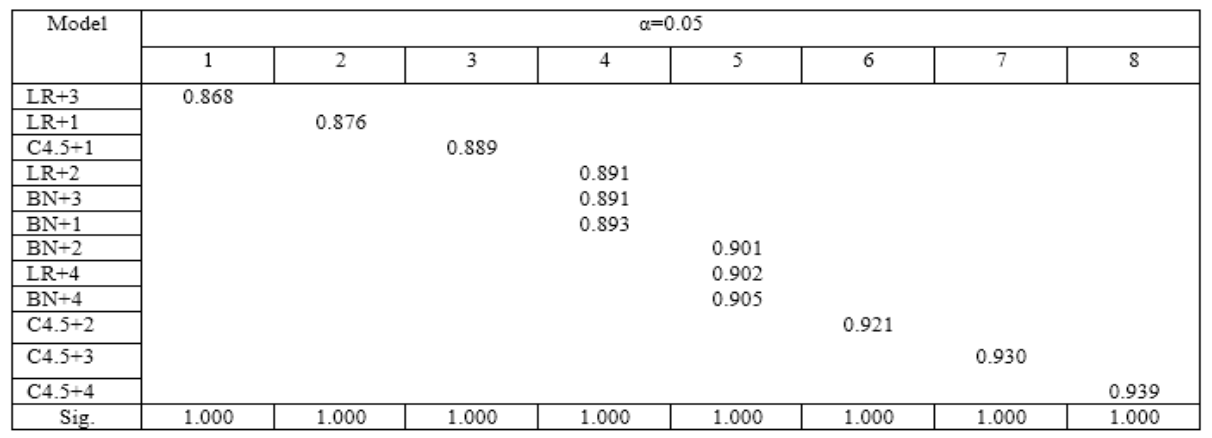
Figure 5. Tukey’s HSD test for Accuracy.